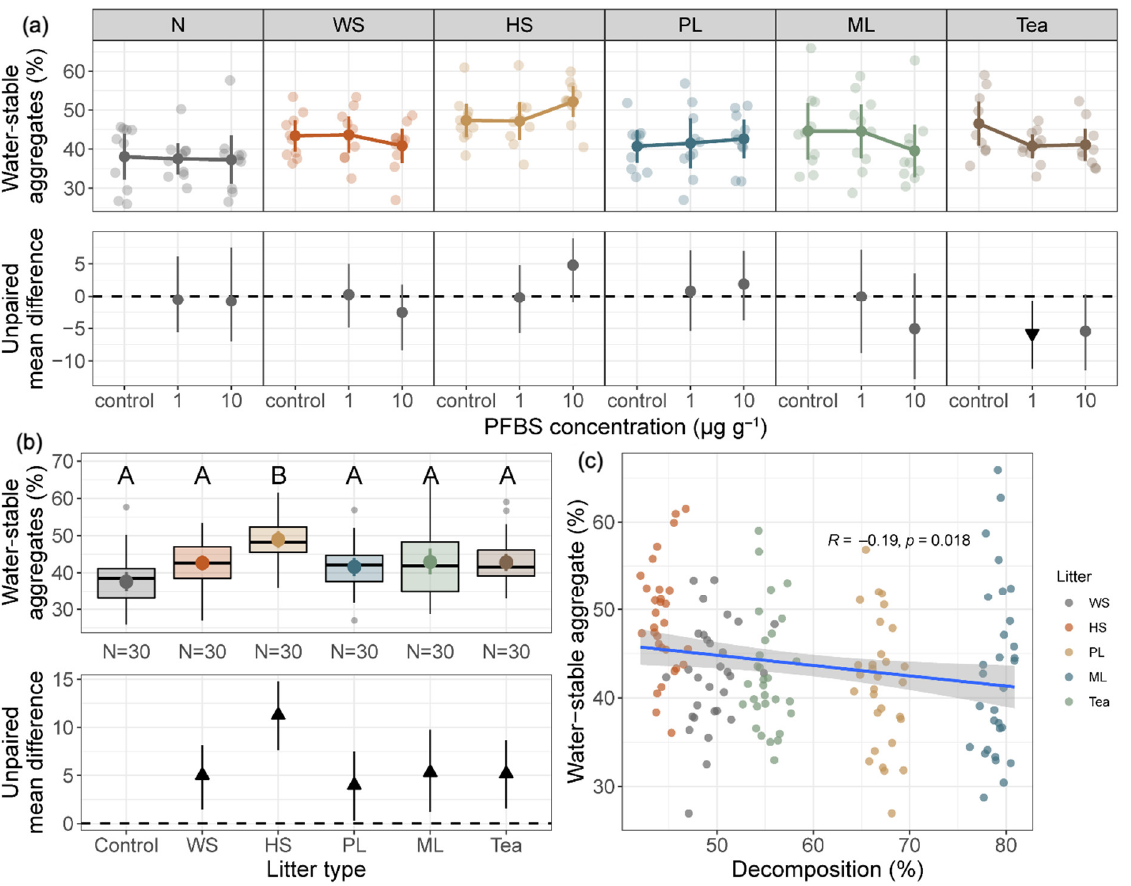
Figure 3. ( a ) Response of water-stable aggregates to PFBS treatments within litter type; ( b ) Response of water-stable aggregates to litter type regardless of PFBS concentrations; ( c ) Correlation of water- stable aggregates with litter decomposition. The second row of the panel ( a ) showed the comparison of the unpaired mean difference between the treated and control group within a 95% confidence interval (CI). The grey spots indicated the neutral effects, while the black arrows pointing downwards represented negative effects. Different letters above boxes in panel ( b ) indicated statistically significant differences among treatments at p < 0.05. N, no litter; WS, wheat straw; HS, hemp stem; PL, Plantago lanceolate ; ML, Medicago lupulina .